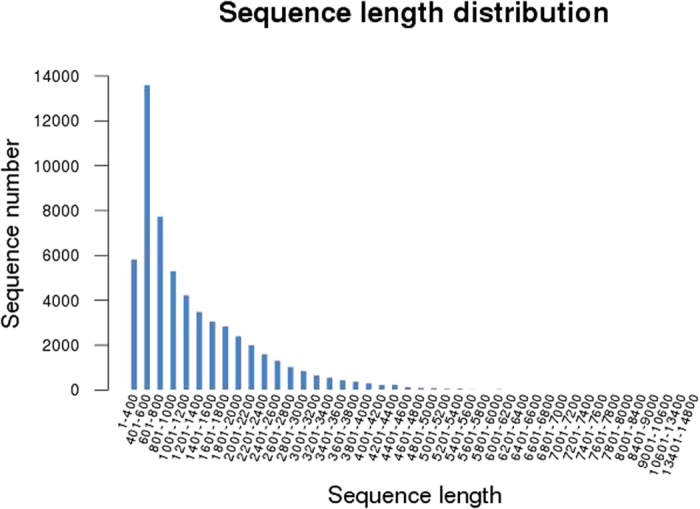
Length distribution of the assembled transcripts.